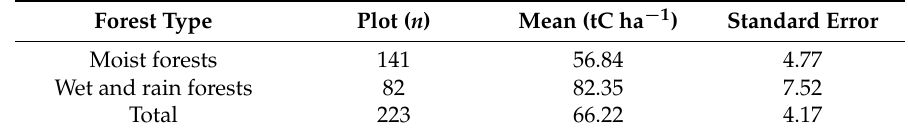
Table 1. Summary statistics for carbon stock in aboveground biomass of living trees with DBH ≥ 2.5 cm. Forest Type Plot ( n ) Mean (tC ha − 1 ) Standard